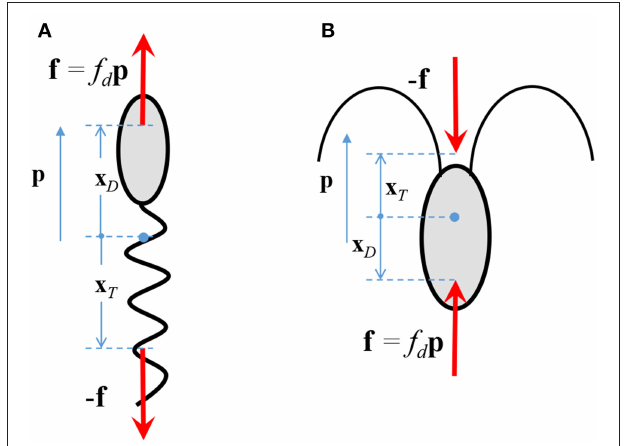
FIGURE 2 | The drag, f d p , and thrust, − f , exerted by a (A) pusher, and, (B) puller, on the surrounding fluid. p is the direction in which the microorganism swims in an unbounded, quiescent